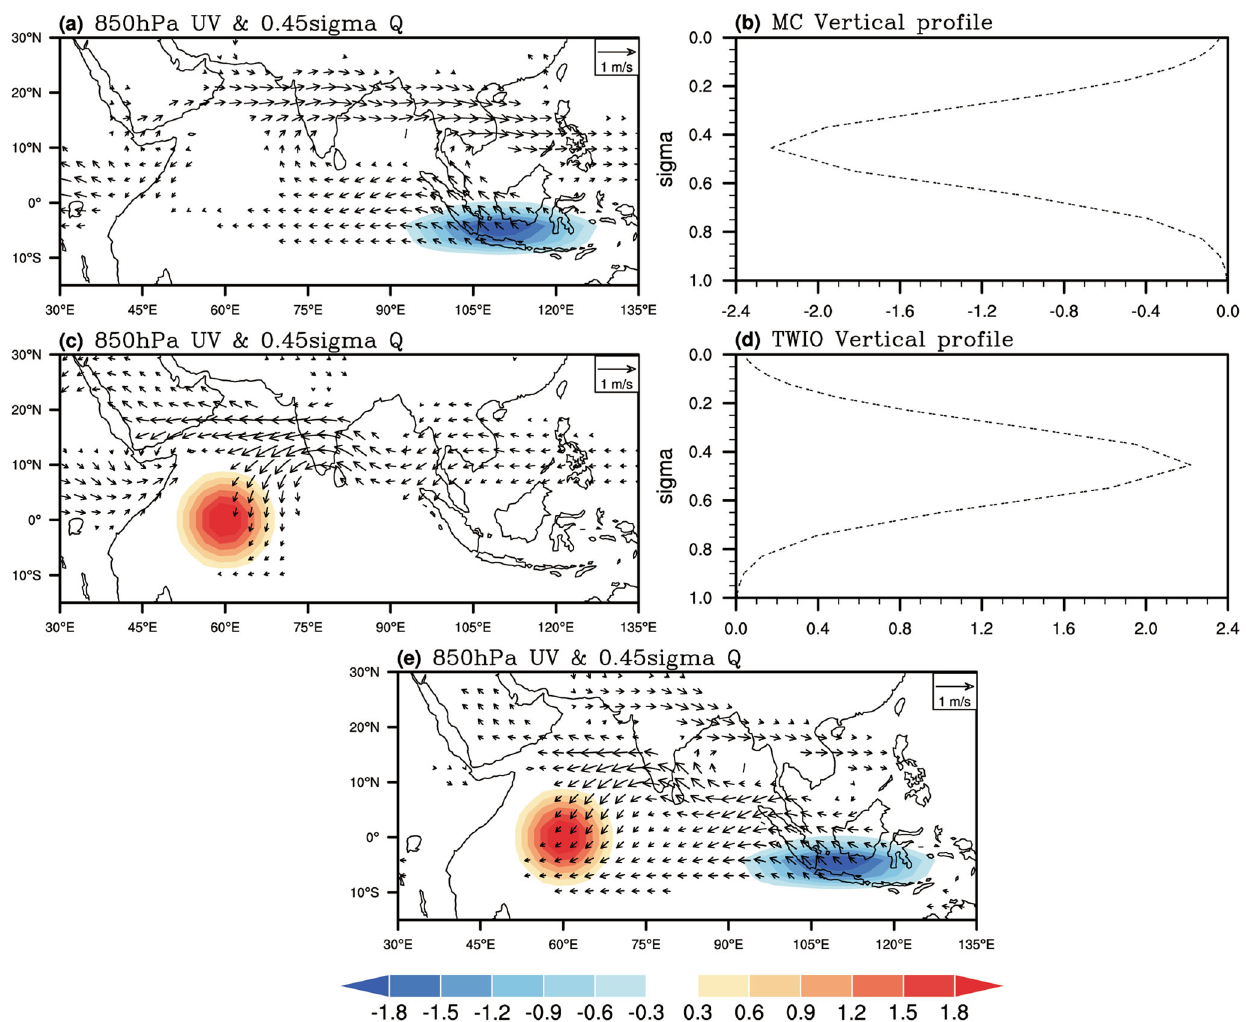
Fig. 7 The response of the LBM to the diabatic forcing. The response of the 850 hPa wind (vectors; unit: m s − 1 ) in the LBM, which is forced by the atmospheric diabatic heating (shadings; unit: K day − 1 ) over the MC ( a ), TWIO ( c ) and the sum of the two ( e ). b , d The vertical distribution of atmospheric diabatic heating over the TWIO and atmospheric diabatic cooling over the MC (unit: K day − 1 ). Wind speed changes less than 0.095 in ( a ), 0.075 in ( c ), and 0.085 in ( e ) are omitted.